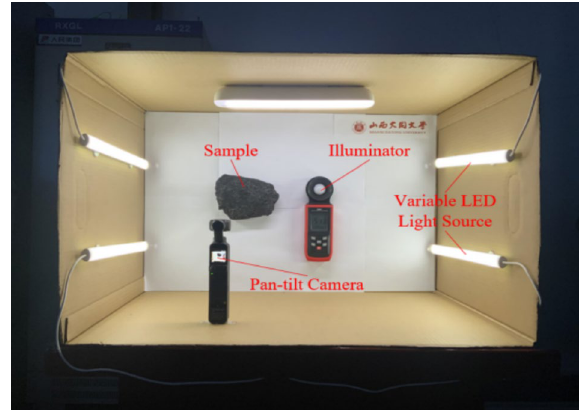
Figure 1. Multi-light source coal and gangue image acquisition